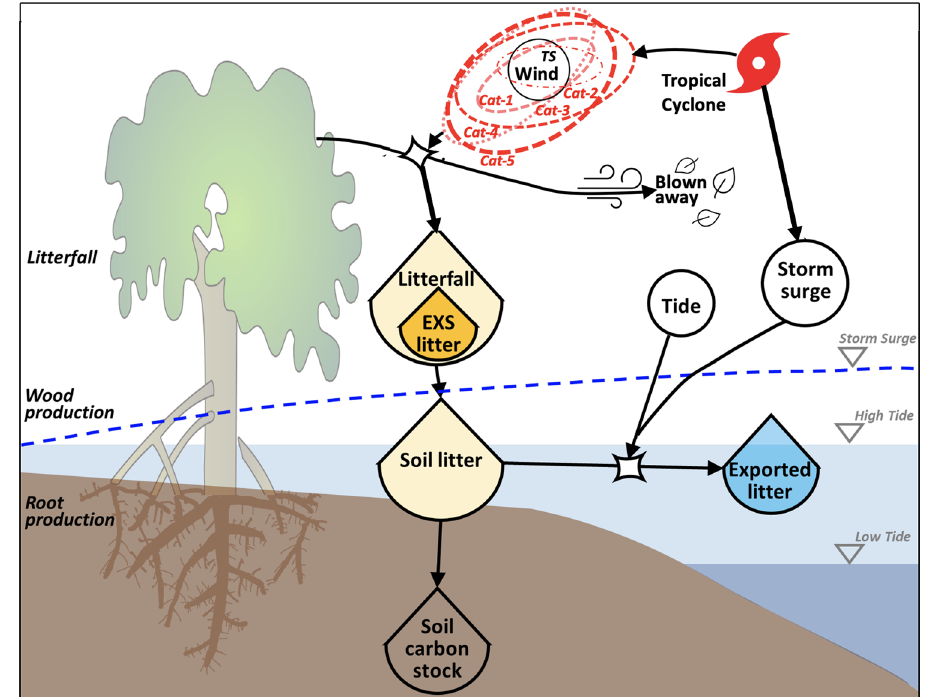
Figure 1. Conceptual diagram showing the impact of tropical cyclones on the mangrove forest canopy and hydrology along the Shark River Estuary. Wind velocity either causes different degrees of canopy defoliation or increases litterfall (i.e., EXS, excess litterfall) that accumulates in the soil (see Methods for EXS value estimation). Depending on the local hydroperiod, surface soil litterfall can be redistributed throughout the mangrove forest or exported to adjacent estuarine waters depending on the maximum water level and storm surge/tide duration. Cat-1, 2, 3, 4, 5 and TS (Tropical Storm) (Saffir-Simpson Hurricane Wind Scale) are storms with different Integrated Kinetic Energy (IKE) (terajoules; see Methods for explanation). Symbols are from Odum’s Energy Systems Language and the Integration and Application Network; https:// www. osti. gov/ biblio/ 55458 93; https:// ian. umces. edu/ symbo